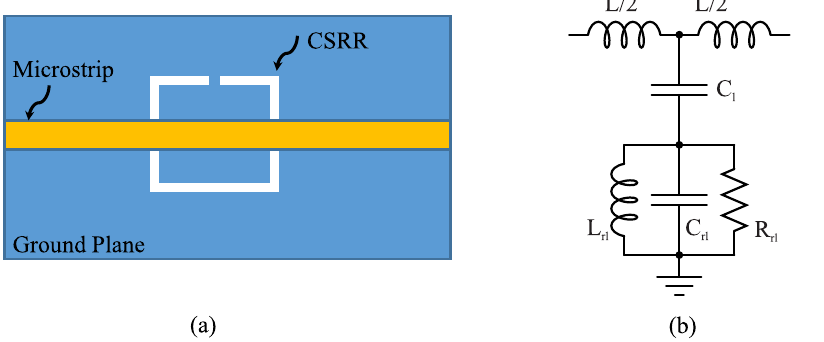
Figure 4. A microstrip line loaded with a CSRR: ( a ) footprint and ( b ) the equivalent lumped circuit model. Reprinted with permission from Ref. [33].